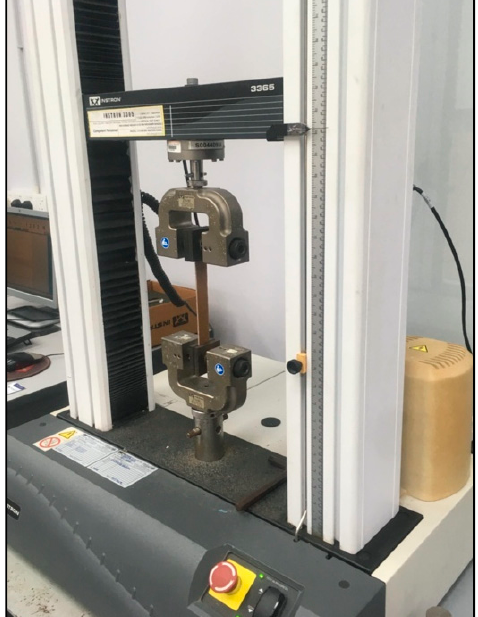
Figure 4. Tensile test setup using an Instron universal testing machine model 3365. a cb